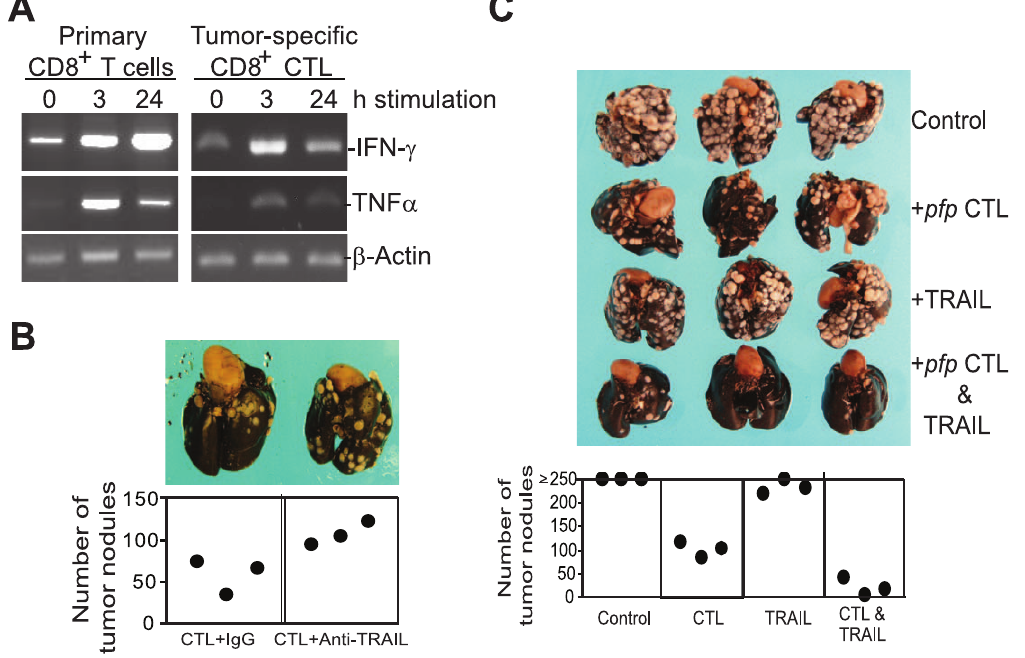
Figure 7. Combined TRAIL therapy and CTL adoptive immunotherapy effectively suppressed colon carcinoma metastasis. A . IFN- c and TNF a expression in activated CD8 + T cells. Primary CD8 + T cells were purified from spleens of naı¨ve mice and stimulated with anti-CD3 and CD28 mAbs for 3 and 24 h, respectively. The tumor-specific CD8 + T cells were stimulated with irradiated tumor cells for 3 and 24 h, respectively. The un- stimulated and stimulated cells were then analyzed for IFN- c and TNF a mRNA level by RT-PCR. B . Function of TRAIL in CTL-mediated tumor rejection. CT26 cells (1 6 10 5 cells/mouse) were injected into mice. Five days later, perforin-deficient CTLs ( pfp CTL, 1 6 10 6 cells/mouse) were mixed with IgG or TRAIL neutralizing mAb (50 m g/mouse) and injected into the tumor-bearing mice. IgG and TRAIL neutralizing mAb (100 m g/mouse) were injected again into the tumor-bearing mice 2 days later. Mice were sacrificed 14 days after CTL treatment and analyzed for lung metastasis. Images of lungs from representative mice are shown. The number of lung tumor nodules was enumerated in a single-blinded fashion. Each dot represents total tumor counts from a single mouse. The difference between CTL + IgG control group and CTL + Anti-TRAIL mAb group is statistically significant ( p =0.03). C . Combined TRAIL and CTL adoptive immunotherapy effectively suppressed colon carcinoma metastasis. CT26 cells (1 6 10 5 cells/mouse) were injected into mice. Five days later, pfp CTLs (1 6 10 6 cells/mouse), TRAIL (200 m g/mouse), or both pfp CTL and TRAIL were injected into the tumor-bearing mice. Mice groups that received TRAIL or both pfp CTL and TRAIL were injected with TRAIL (200 m g/mouse) again every 2 days for 4 more times. Mice were sacrificed 16 days after tumor transplantation and analyzed for lung metastasis. The number of lung tumor nodules was enumerated in a single- blinded fashion. Each dot represents total counts from a single mouse. Counts greater than 250 are expressed as $ 250. The difference between control and TRAIL treatment group is not statistically significant ( p =0.15). The differences between control and pfp CTL treatment alone group and between control and pfp CTL + TRAIL treatment group are both statistically significant ( p ,